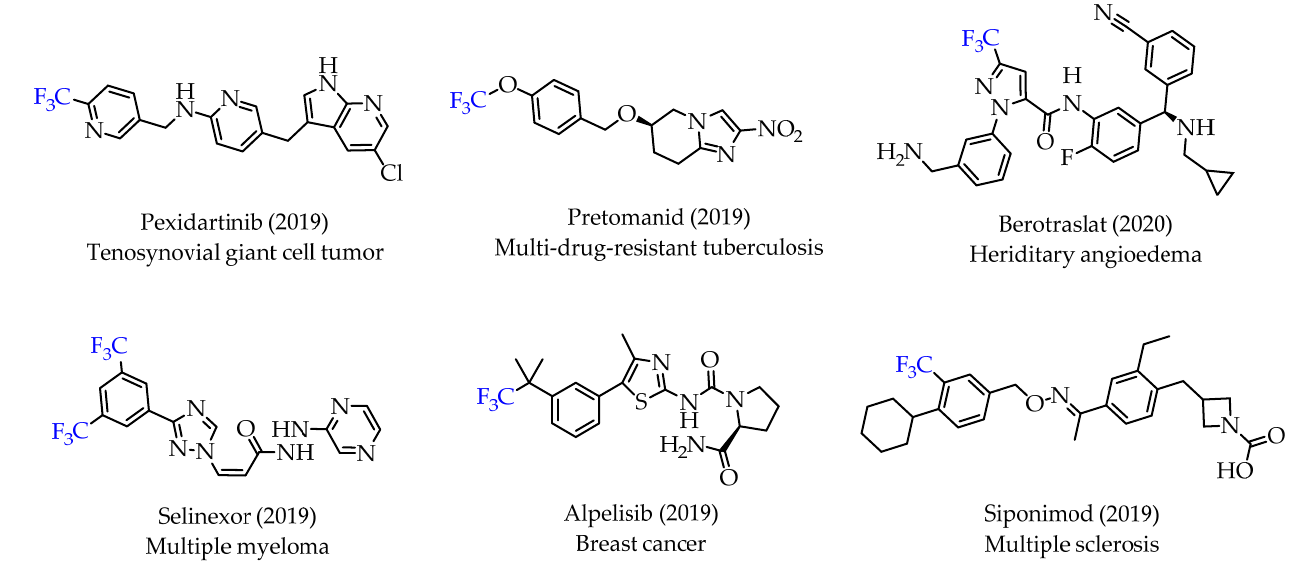
Figure 1. Representative examples of recently approved drugs with trifluoromethyl groups.